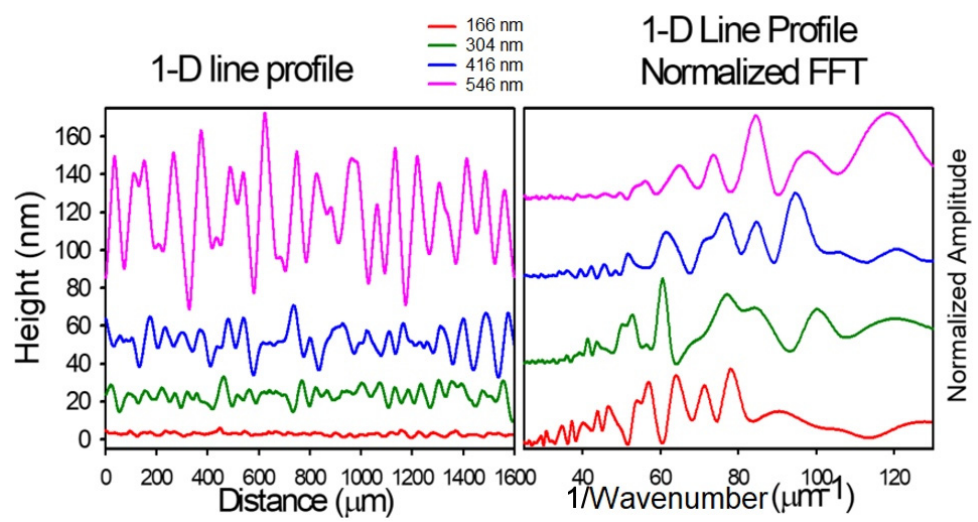
Figure 3. One-dimensional line profiles of PMMA surfaces at locations where convection rolls are present. ( Left ) PMMA surface 1D line profiles. ( Right ) Height normalized Fast Fourier Transforms of the corresponding line profiles. Films were cast using 2.5, 4.0, 5.0, and 6.0 g/dL solutions spun at 1200 RPM.